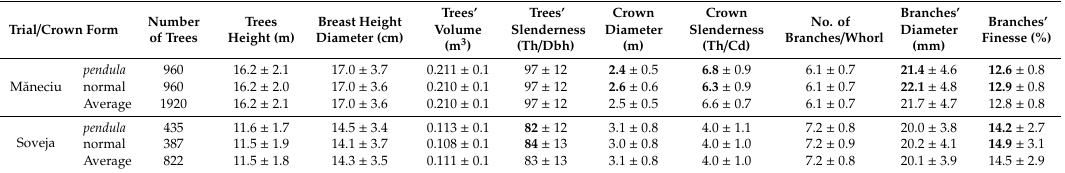
Table 2. Mean values ( ± standard deviation) for phenotypic traits at the crown form level in the M ă neciu and Soveja trials (significant di ff erences between forms are in bold). Trial / CrownForm Number ofTrees Trees Height(m) BreastHeight Diameter(cm)